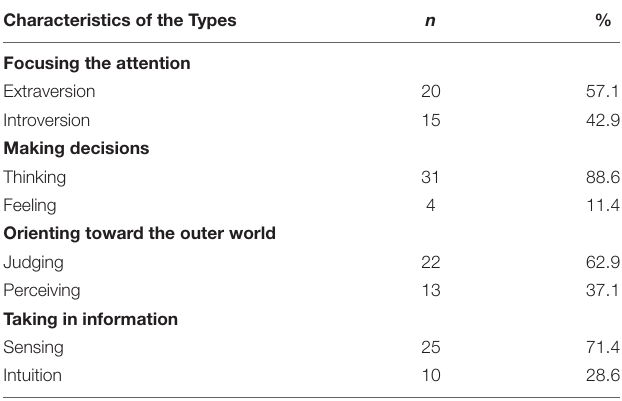
TABLE 3 | Percentage of participants according to the basic characteristics of the Types.